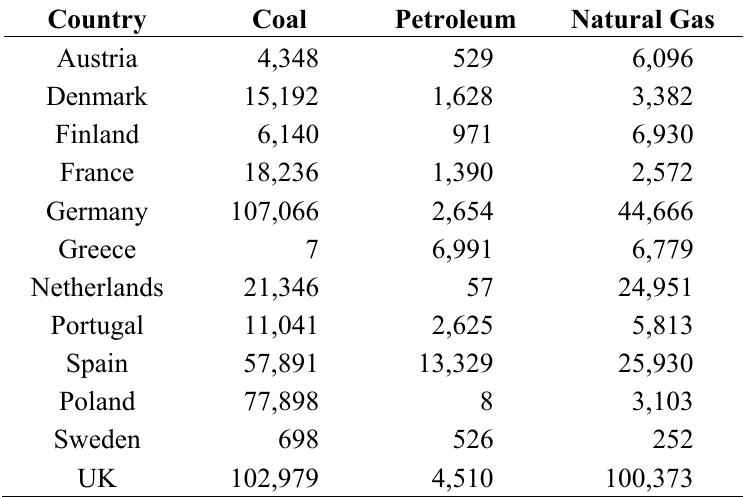
Table 2. Average annual fossil fuel consumption in terajoules, January 2004 to March